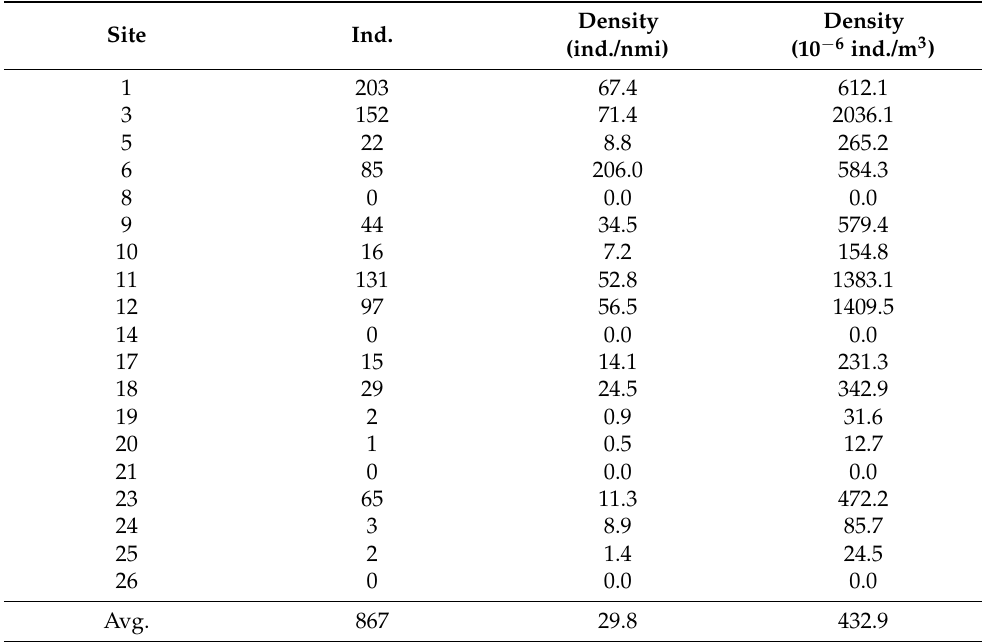
Table 8. Distribution density of jellyfish using the trawl survey method in the Southern Sea and Jeju coastal waters.